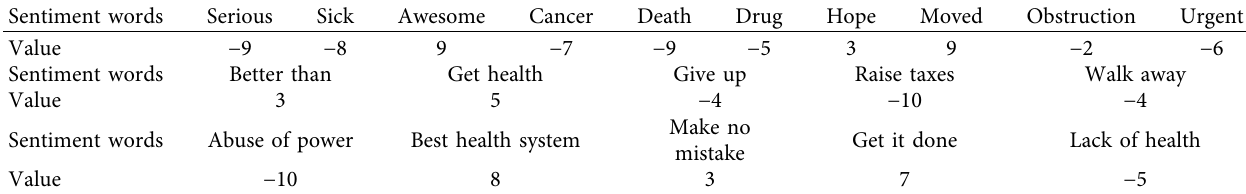
Table 3: Some example words in the sentiment lexicon, which is generated based on the HCR